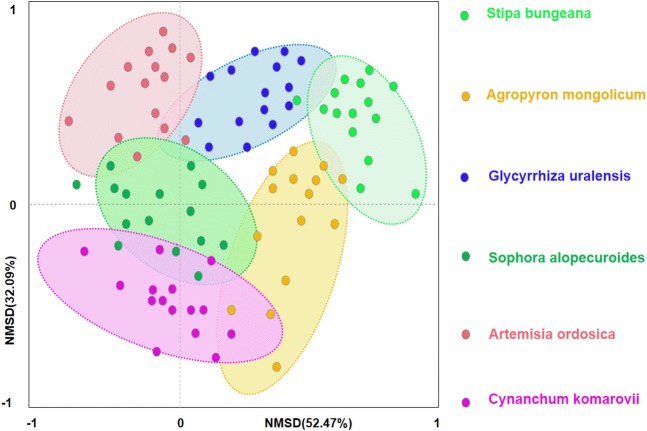
Nonmetric multidimensional scaling (NMDS) ordination of different plant communities in desertified steppe.